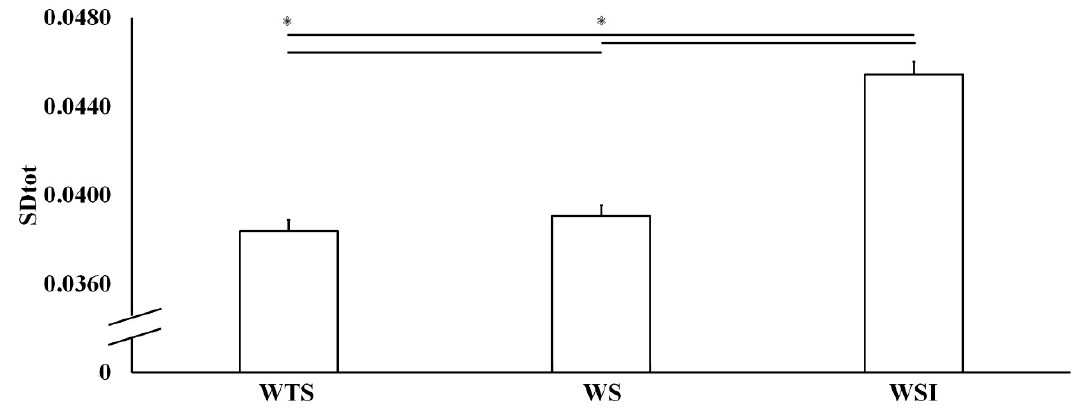
Figure 3. Standard deviation of cycle-to-cycle intervals (SDtot) on WTS (without shoes), WS (with shoes), WSI (with shoes and insoles). Statistical significance is denoted as “*” p < 0.001 between the two walking conditions.